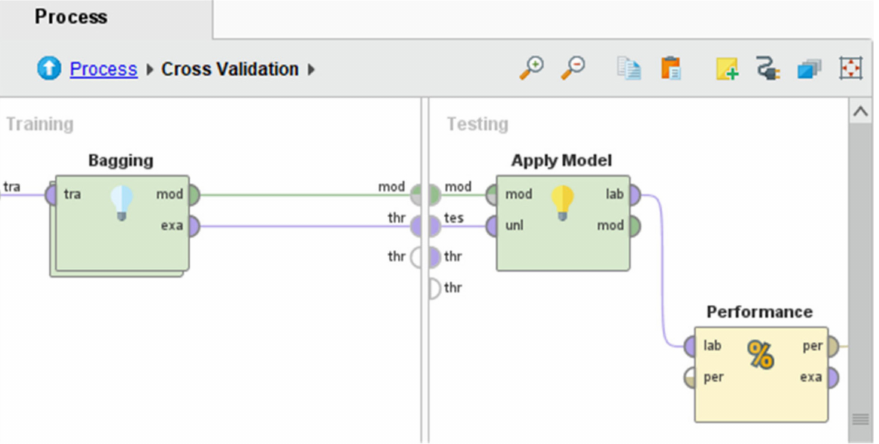
Figure 4. Model implementation using bagging (step